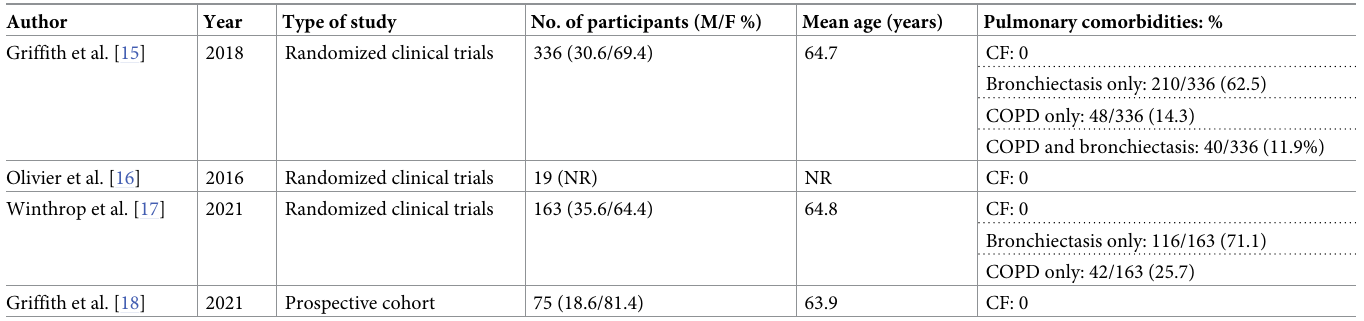
Fig 1. Study selection flow chart for the studies in the systematic review. https://doi.org/10.1371/journal.pone.0279714.g001 Table 1. Included